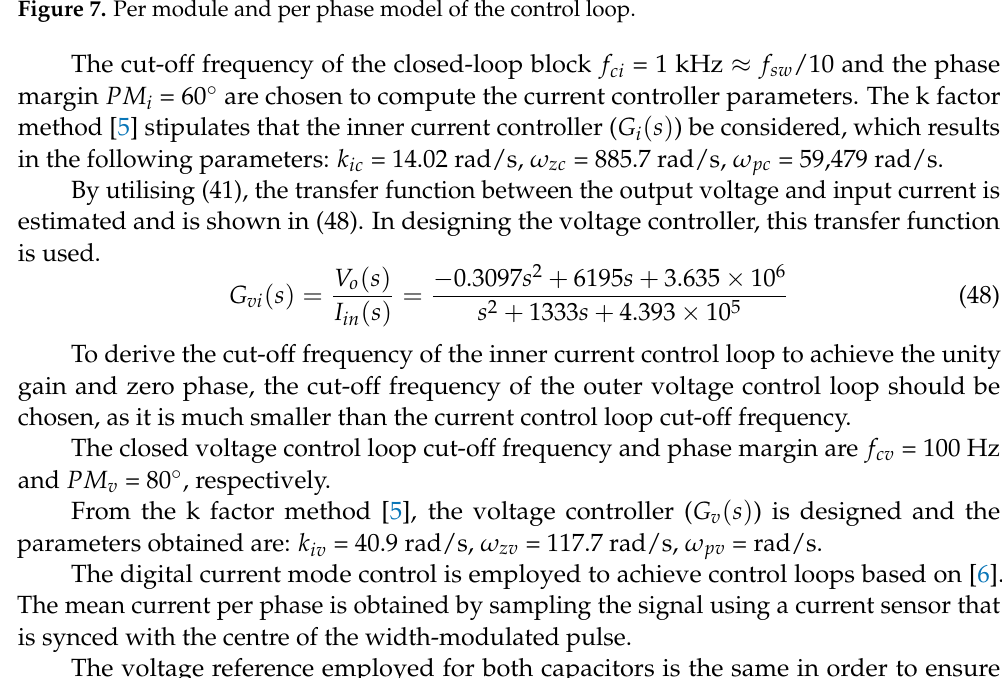
Figure 7. Per module and per phase model of the control loop.